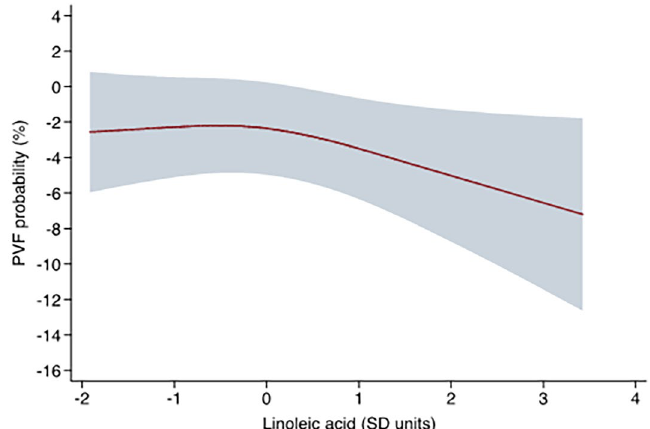
Figure 2. Adjusted predictions with the 95% confidence interval for the relationship between standardized linoleic acid (C18:2n-6) values and the occurrence of primary ventricular fibrillation (PVF). Standardized C18:2n-6 values were modeled by restricted cubic splines. All predictors were set to their mean values.